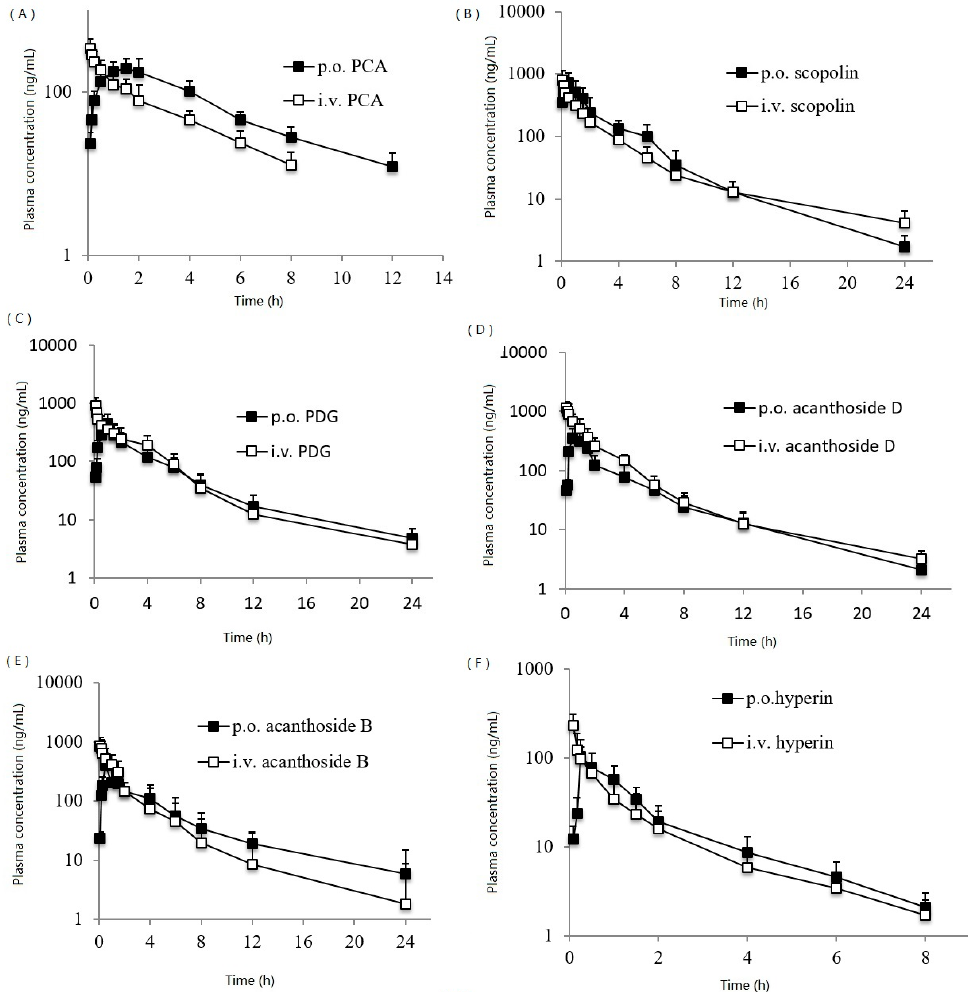
Figure 3. Plasma concentration–time profiles in the Sprague–Dawley rat. ( ): oral administration of the extracts of A. sessiliflorus fruits to the Sprague–Dawley rat at 800 mg/kg (calculated as the total amount of extracts), ( □ ): intravenous injection route. p.o.: per oral, i.v: intravenous injection. Table 3. Mean pharmacokinetic parameters for Protocatechuic acid (PCA), Scopolin, ( − )-pinoresinol- 4,4’-di- O - β - D -glucopyranoside (PDG), Acanthoside D, Acanthoside B and Hyperin in rat plasma after